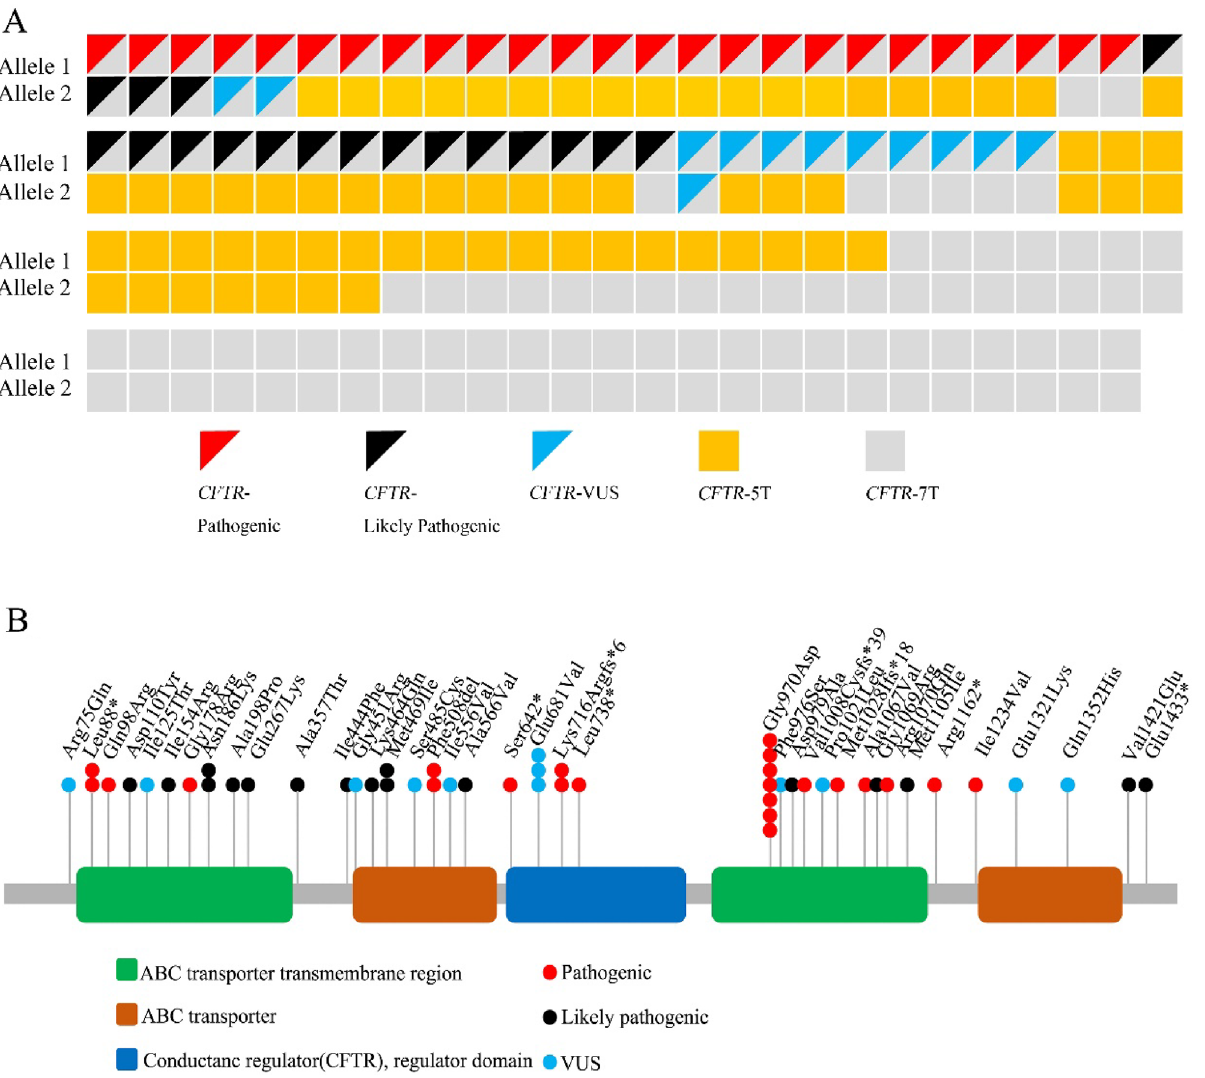
Figure 2. CFTR gene variants. ( A ) Pathogenic variants, Likely Pathogenic variants and variants of uncertain significance (VUS) of CFTR are shown for the 103 CAVD patients. ( B ) The CFTR variants leading to amino acid changes are marked onto protein domains.